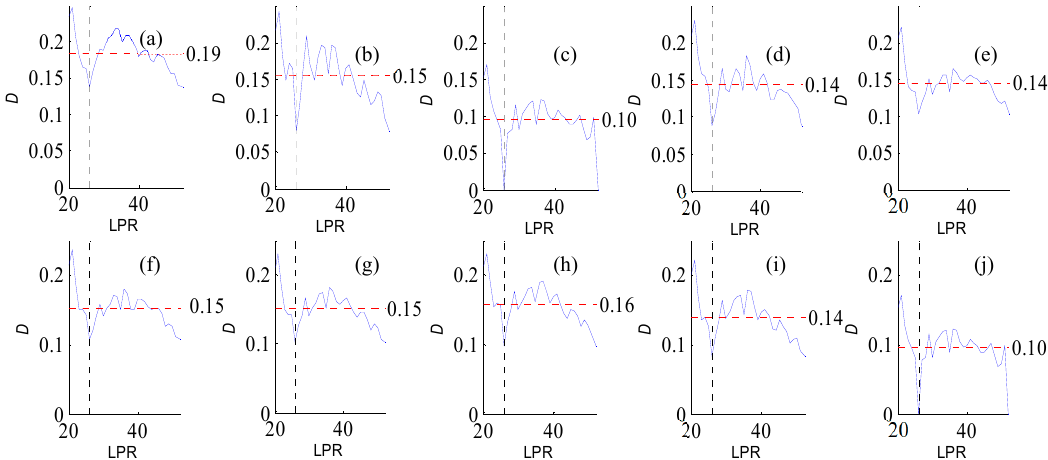
Figure A3. Variation of flow regime alteration degree (D) measured by the RVA with change in the